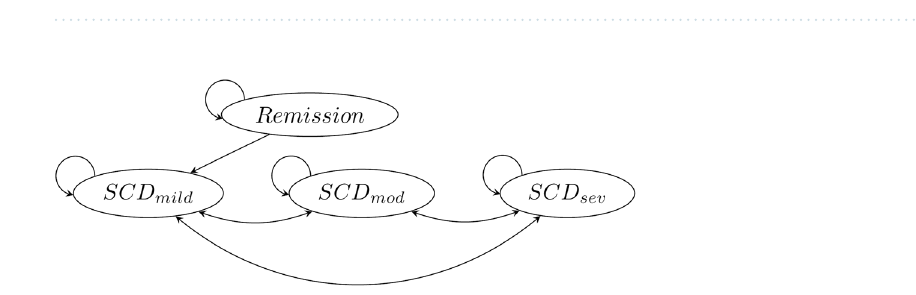
Table 1. Model input parameters and probabilistic sensitivity analysis distributions. PSA probabilistic sensitivity analysis, DSA deterministic sensitivity analysis, GLM generalized linear model. a Confidence intervals omitted for variables drawn from multivariate distributions. b Not varied in DSA. c Truncated normal distribution on [0,1].